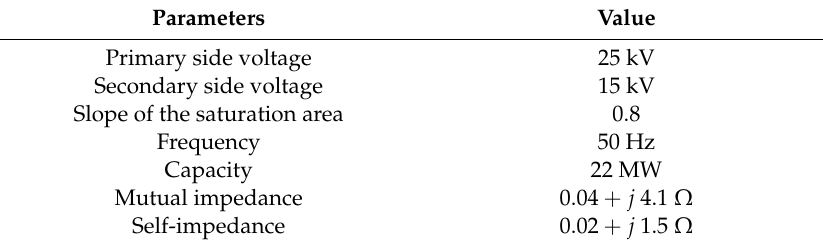
Table 4. EMU transformer